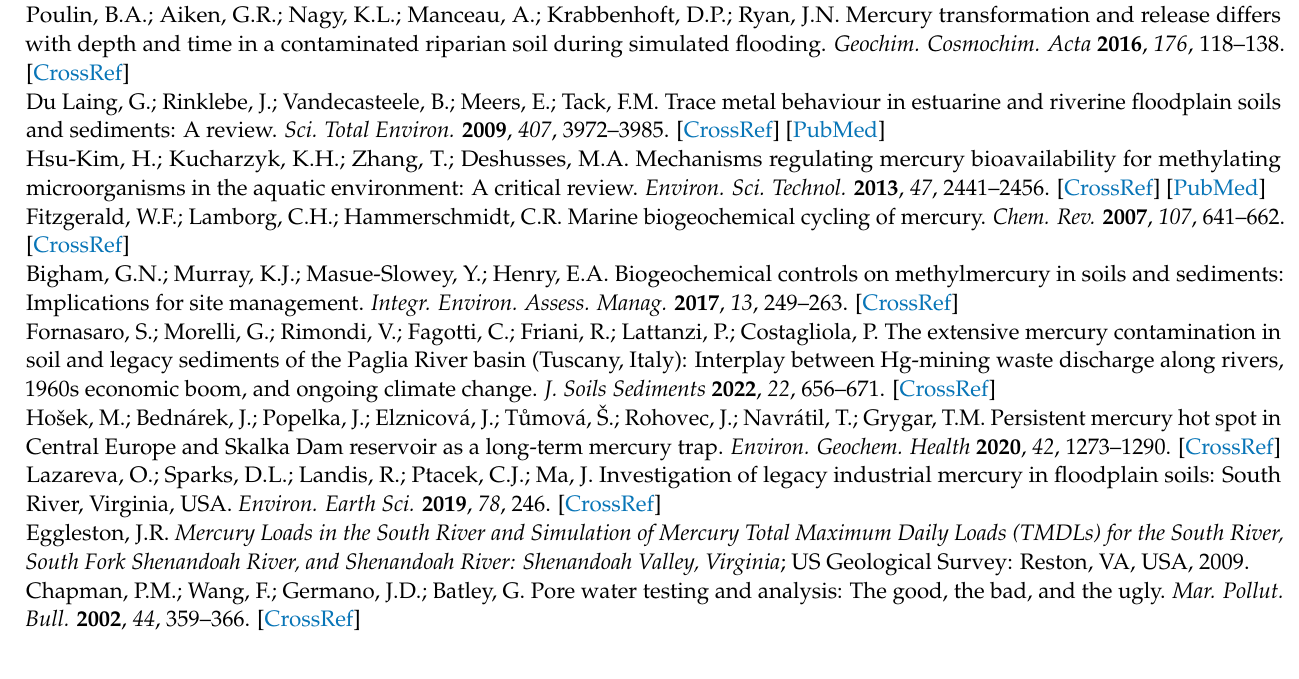
Figure S4: Redox Potential during Drainage condition in 2018 in bank locations of Constitution Park, Figure S5: Redox Potential during baseline condition in 2020 in bank locations of Constitution Park. The location 3 and location 5 were both rocky so the point that was selected was between these two locations, Table S3: Bromide mass-transfer coefficients and estimates of interstitial water velocity from equilibrium diffusion